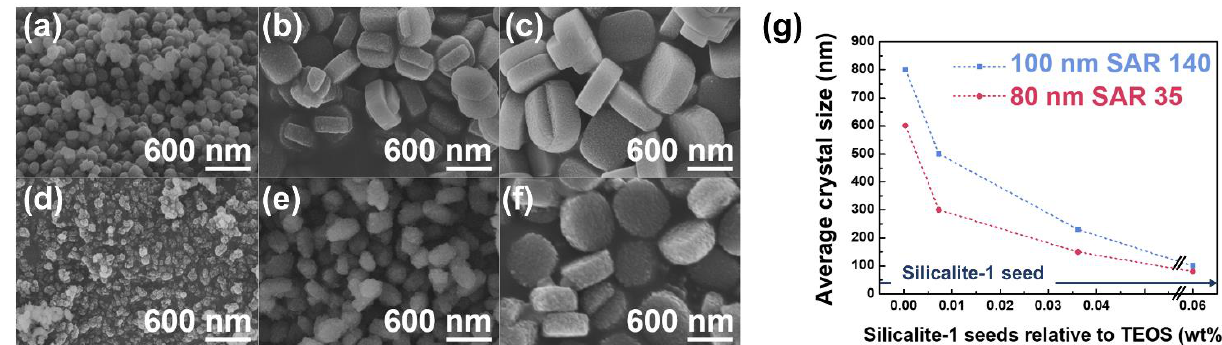
Figure 4. Changes in the crystal size of the samples depending on the relative amounts of the silicalite-1 seed and Si/Al nutrients. SEM imagery of the zeolite samples with ( a – c ) SAR = 140; and ( d – f ) SAR = 35. The precursor sol composition was 4050 H 2 O:4.5 TPAOH:20 SiO 2 :x Al 2 O 3 :2x NaOH, where the values of x were 0.07 and 0.29, while the relative amount of silicalite-1 seeds was 0.18 wt% for ( a ) and ( d ), 7.24 × 10 −3 for ( b ) and ( e ) and 3.62 × 10 −4 wt% for ( c ) and ( f ). Growth was conducted at 150 °C for 48 h; ( g ) changes in crystal size according to relative ratio of silicalite-1 seeds and silica/alumina nutrients. The average particle size of silicalite-1 seeds is marked by the dark blue line.